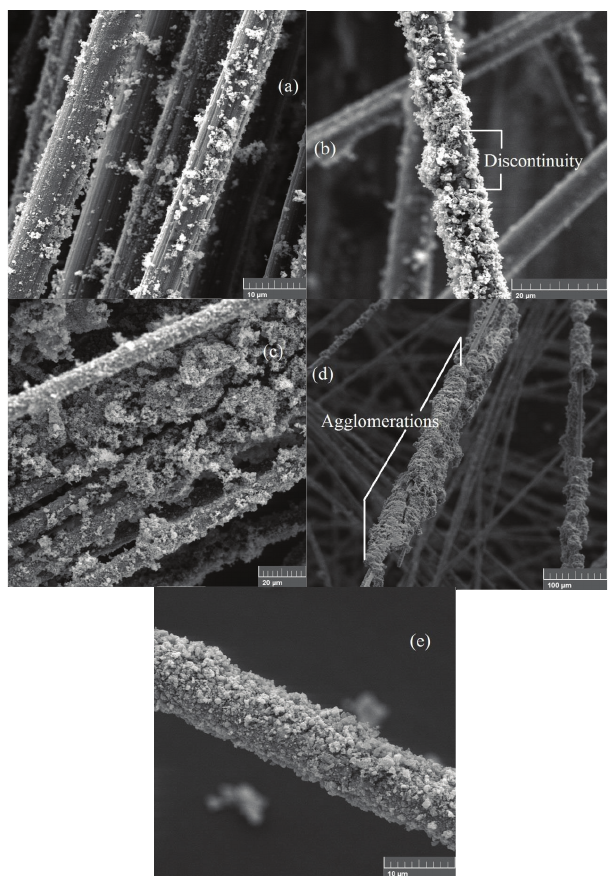
Fig. 3. FE-SEM images of magnetite coated carbon fibers coated in 2 (a) 4 (b) 8 (c) and 12 minutes (d) and prepared with a three step deposition process (e).